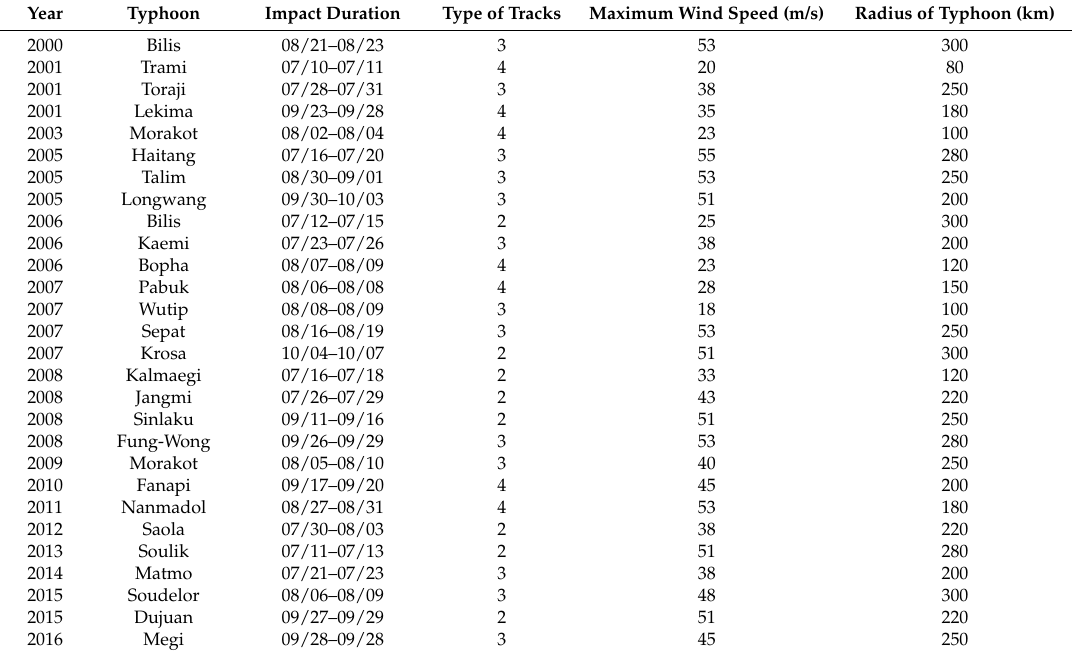
Table 1. Basic information of typhoons collected from 2000 to